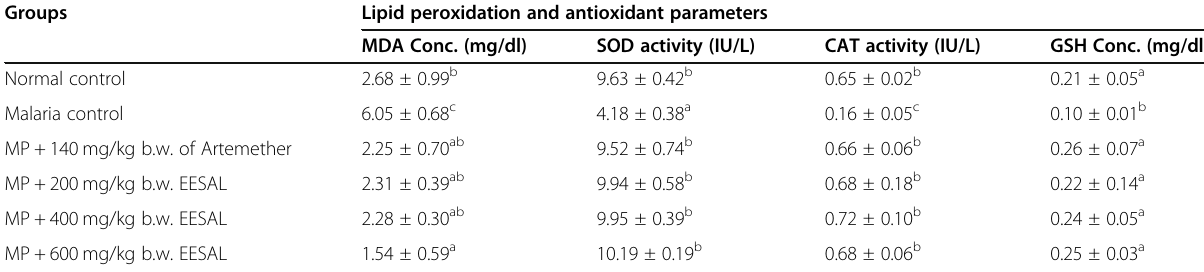
Table 6 Effect of the EESAL on lipid peroxidation and antioxidant parameters of Plasmodium berghei -infected mice Groups